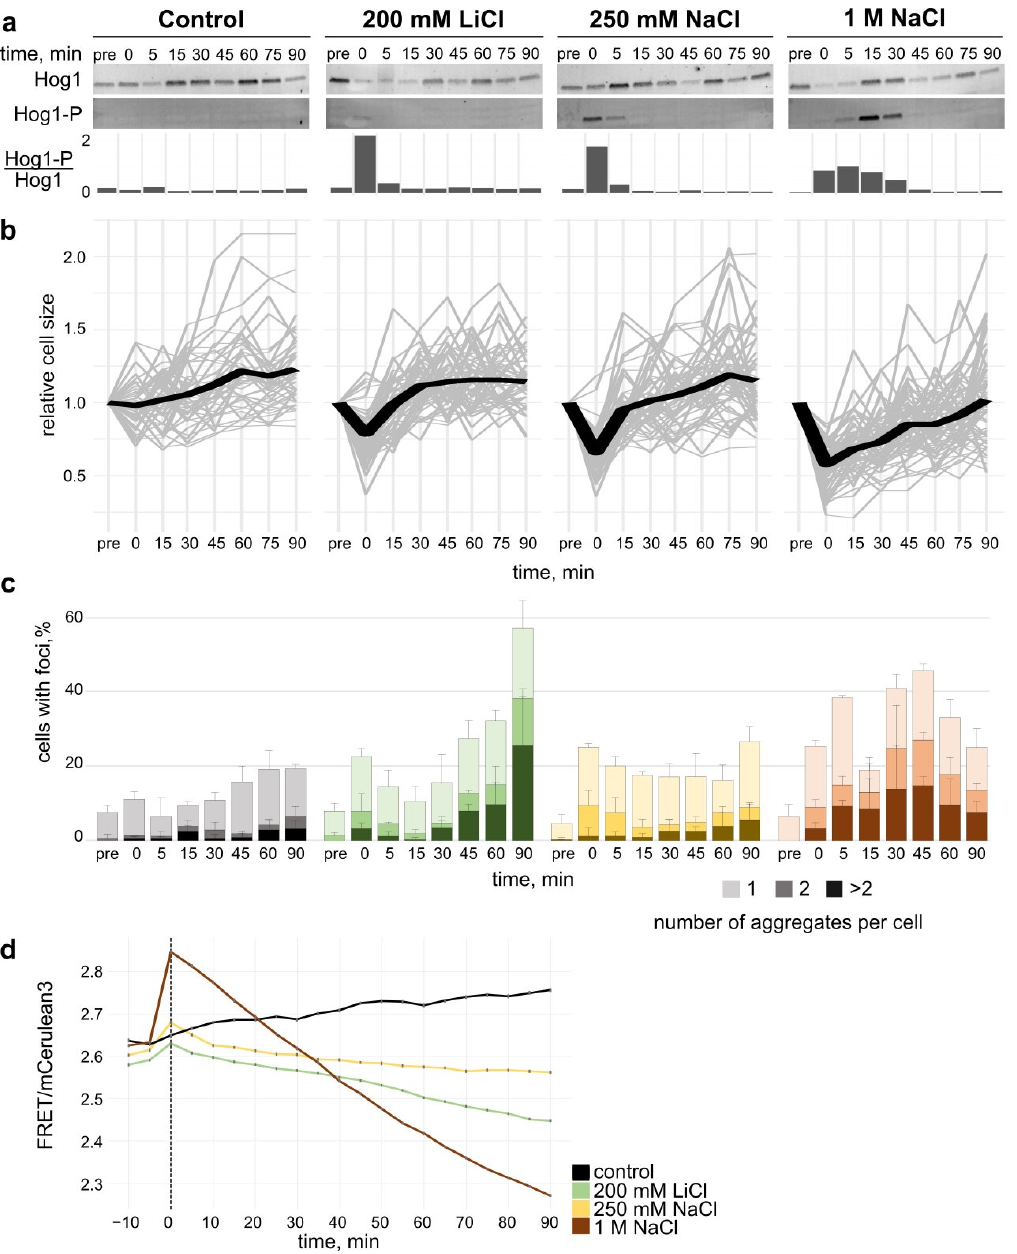
Figure 2. Assessment of impact of salt stress on yeast cells. ( a ): Activation of the HOG pathway upon salt stress. Western blot of Hog1 phosphorylation in S. cerevisiae before and up to 90 min after addition of salt stress. Hog1-P/Hog1 is the ratio of the Hog1 phosphorylation signal divided by the signal for the total Hog1. ( b ): Cell volume recovery upon osmotic upshift. Relative cell size was characterised by change in circumference of the cells observed in the microscope. Single cell trajectories (grey) and the average (black) are shown. ( c ): Salt stress induced aggregation in yeast cells. Percentage of cells with Hsp104-GFP foci before and after application of salt stress. Colour shades represent the number of aggregates per cell; at least 100 cells per timepoint and condition were assessed. Error bars indicate SD ( d ): NaCl and LiCl stress recovery and crowding. FRET/mCerulean3 ratiometric plot before and after salt upshift (vertical line). Cells were imaged every 5 min for 10 min prior and 90 min after the media exchange to the standard SDM (grey), 1 M NaCl (red), 250 mM NaCl (yellow), and 200 mM LiCl (green). One out of three representative experiments is shown. Error bars indicate